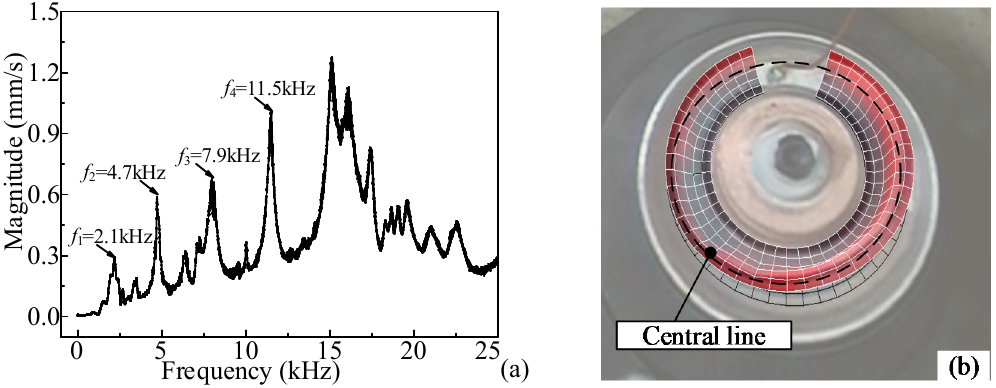
Figure 15. The vibration measurement results of vibrator: ( a ) the vibration velocity response spectrum; ( b ) the first order vibration shape.